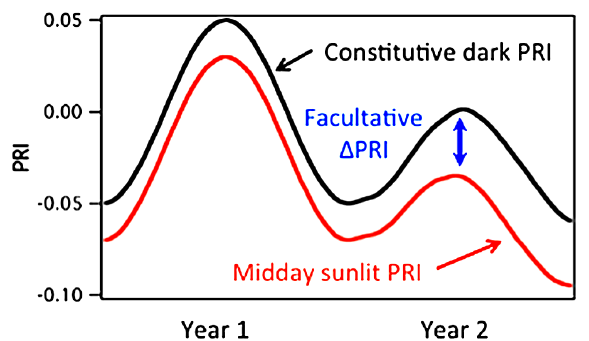
Figure 5. Representation of the LUE model (Eq. 2), showing op- tical measurements useful for model parameterization and valida- tion (red text), including solar-induced fluorescence, the NDVI, the PRI, and fluorescence yield ( (cid:49) F / Fm (cid:48) ). Alternatively, efficiency ( ε ) can be addressed using meteorological data (temperature and vapor pressure deficit) according to Eq. (3), or can be addressed with ther- mal remote sensing and modeling methods (Anderson et al., 2008; Schull et al., 2015). To most directly compare with eddy covariance, which measures NEE (analogous to NPP), additional modeling, or partitioning into gross ecosystem production (GEP, analogous to gross primary production, GPP) and respiration ( R ), is